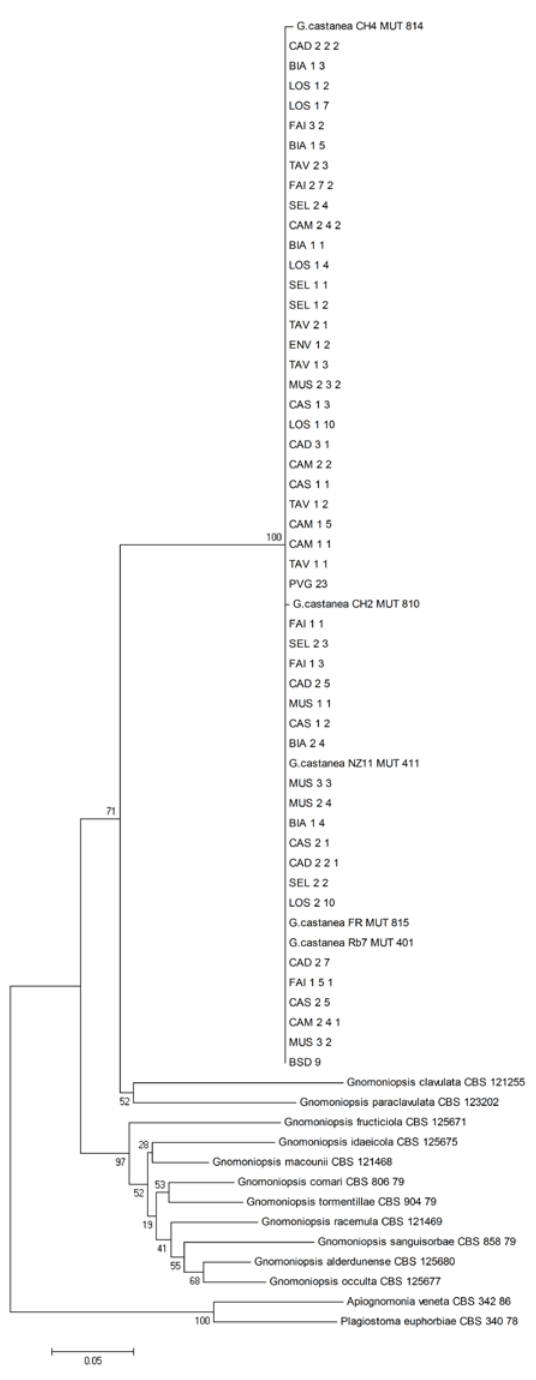
Figure 3. Neighbour-joining tree of EF-1α sequences. No differences were found between the isolates from this study and Gnomoniopsis castanea reference isolates. Gnomo- niopsis clavulata and G. paraclavulata are confirmed to be the closest relatives of G. castanea